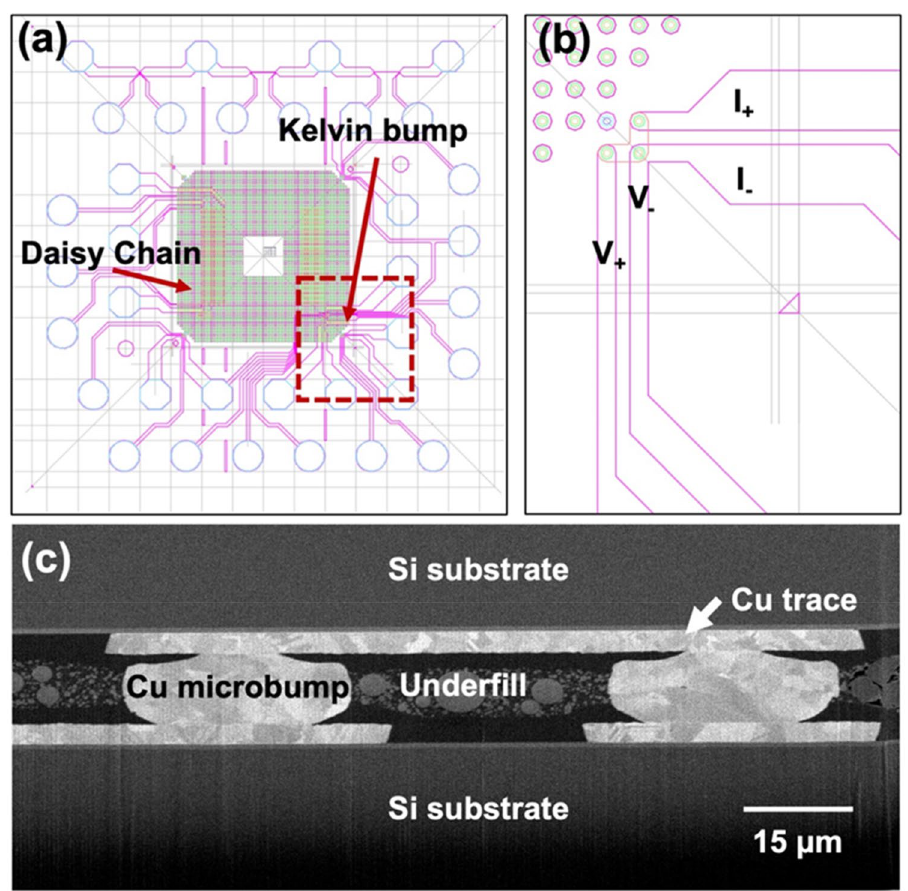
Figure 3. ( a ) Typical layout and ( b ) enlargement of the Kelvin microbump structure. ( c ) Cross-sectional SEM image of the Kelvin microbumps after 1000 thermal